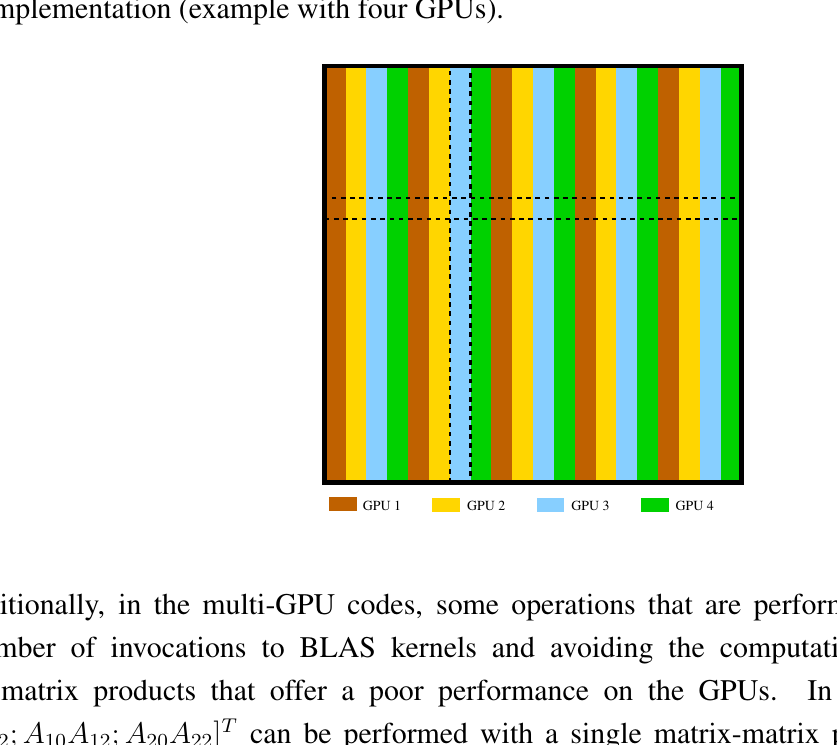
Figure 1. Data distribution between graphics processing units (GPUs) for the multi-GPU implementation (example with four